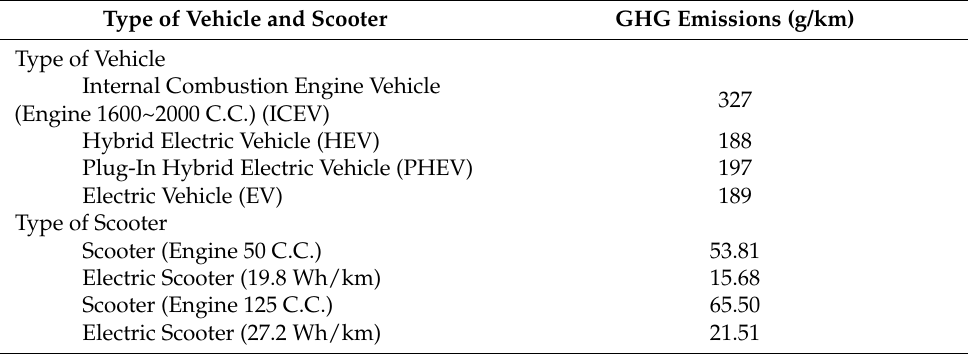
Table 1. GHG emissions from the life-cycle approach (LCA) for different types of vehicles and